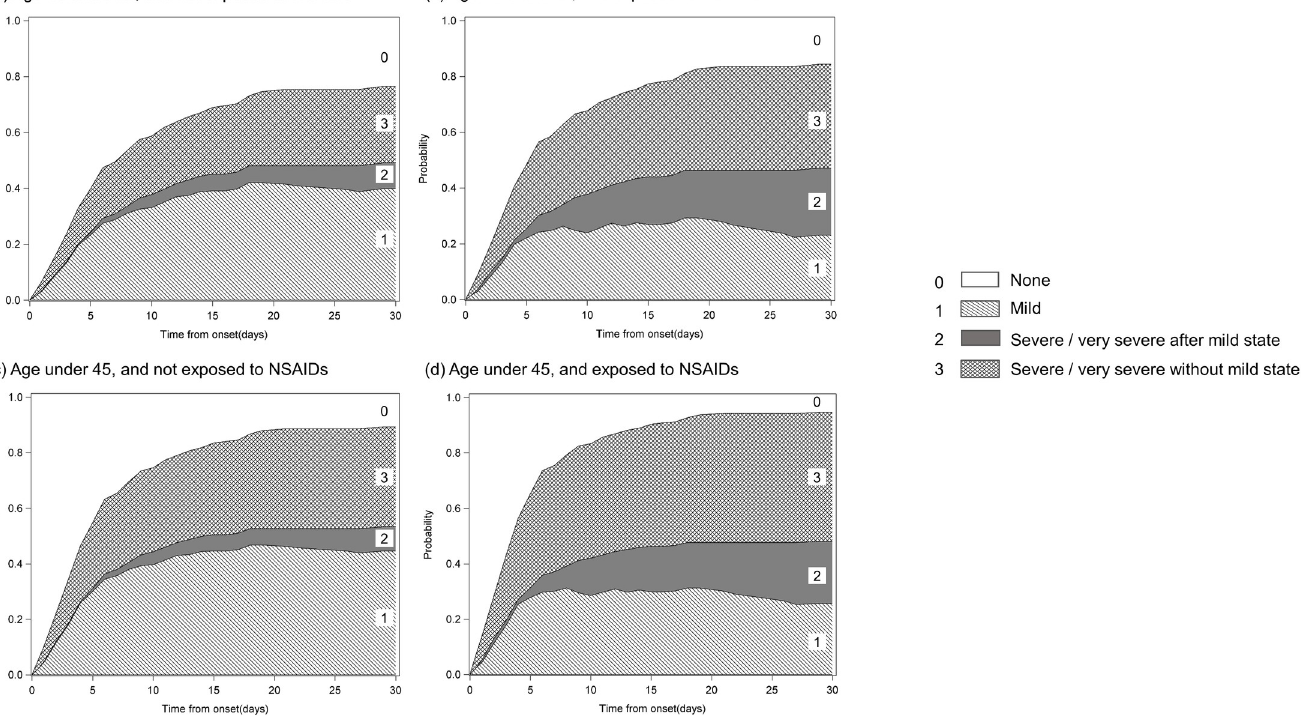
Fig 4. Stacked prediction probabilities of acute ocular severity in SJS/TEN patients stratified by age categories and with or without exposure to nonsteroidal anti-inflammatory drugs (NSAIDs). ( a ) Age 45 and over with no exposure to NSAIDs. ( b ) Age 45 and over with exposure to NSAIDs. ( c ) Age under 45 with no exposure to NSAIDs. ( d ) Age under 45 with exposure to